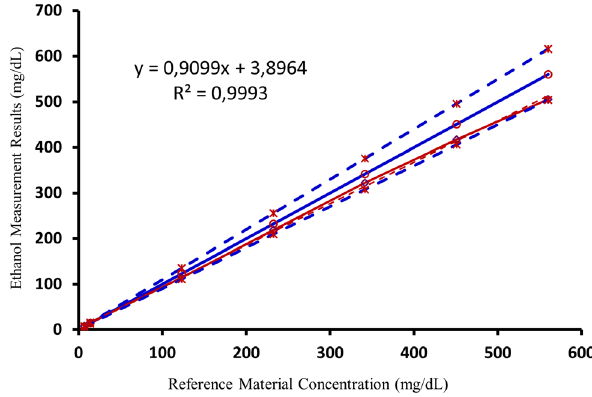
Figure 1: Linearity graph of the enzymatic ethanol analysis